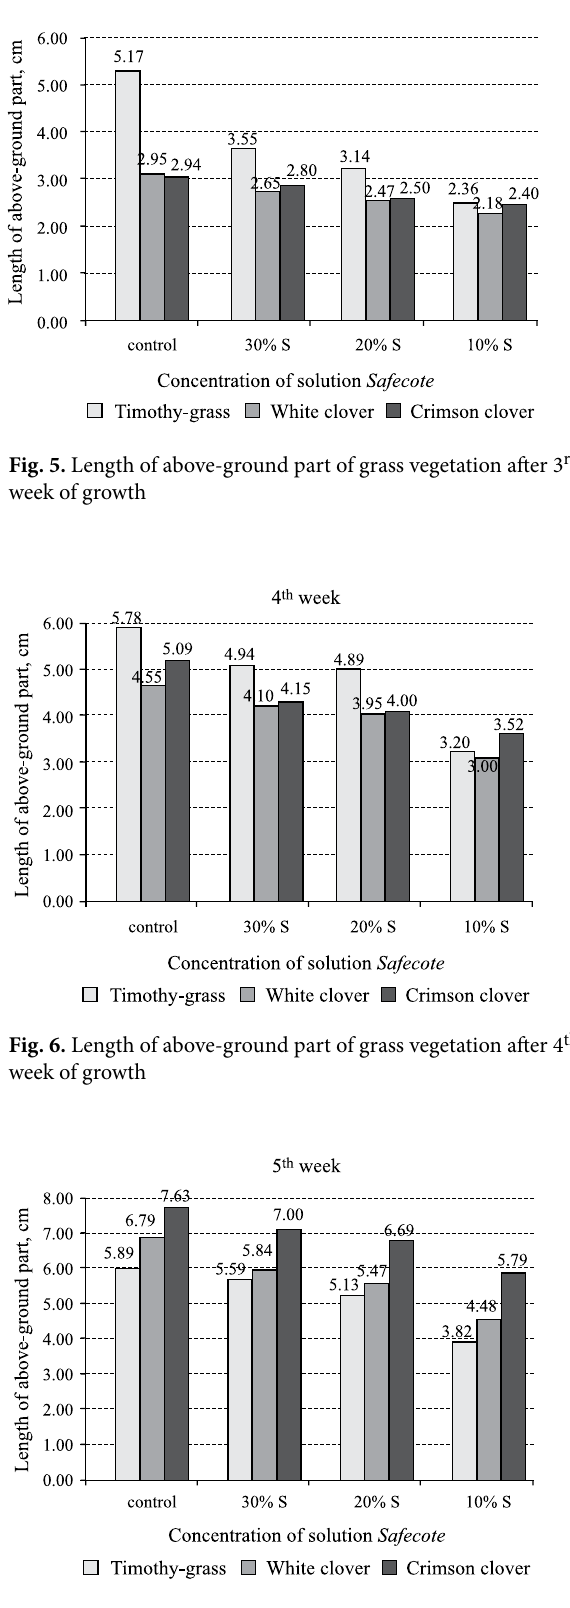
Fig. 7. Length of above-ground part of grass vegetation after 5 th week of growth